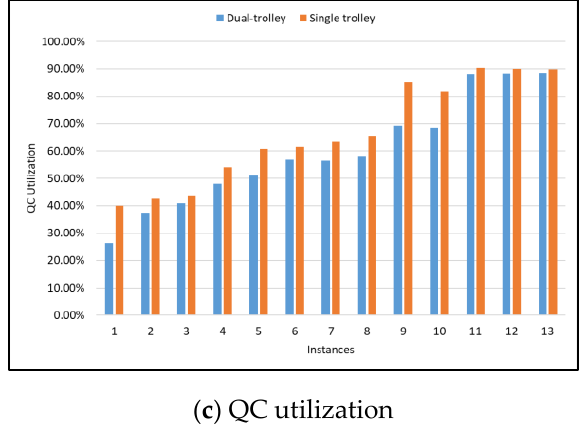
Figure 6. Comparison of using dual-trolley QCs and single-trolley QC ( a – c ) .